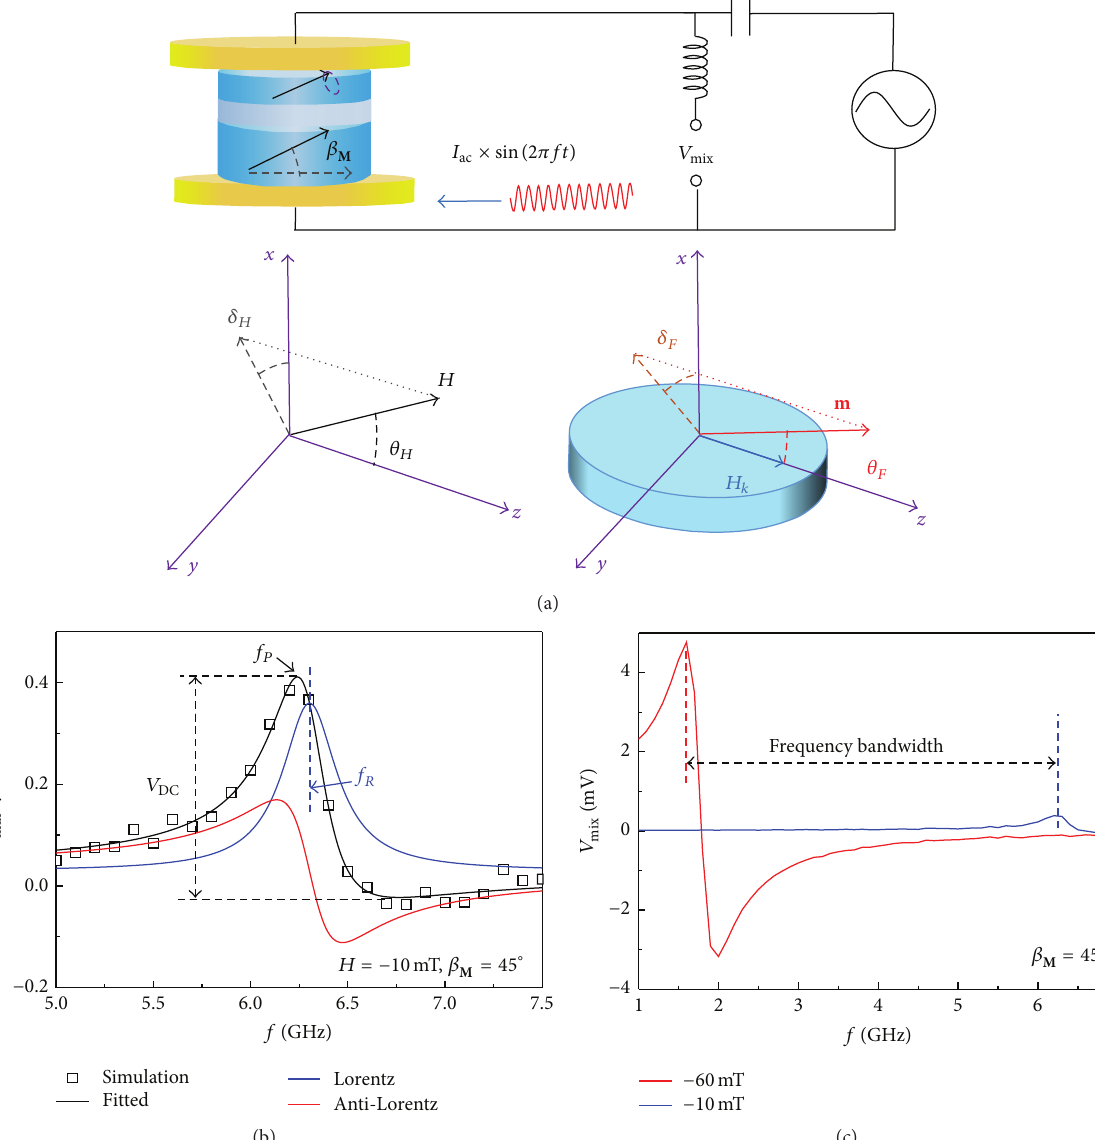
Figure 1: (a) AC is injected into an STMD under magnetic field ( 𝐻 ) applied at (𝜃 𝐻 , 𝛿 𝐻 ) , and the free-layer magnetization (𝜃 𝐹 , 𝛿 𝐹 ) precesses around its equilibrium; (b) a typical 𝑉 mix - 𝑓 spectrum can be decomposed into a Lorentz peak and an anti-Lorentz curve; (c) frequency bandwidth is defined as frequency gap of 𝑓 𝑃 at 𝜇 0 𝐻 = − 10mT and −